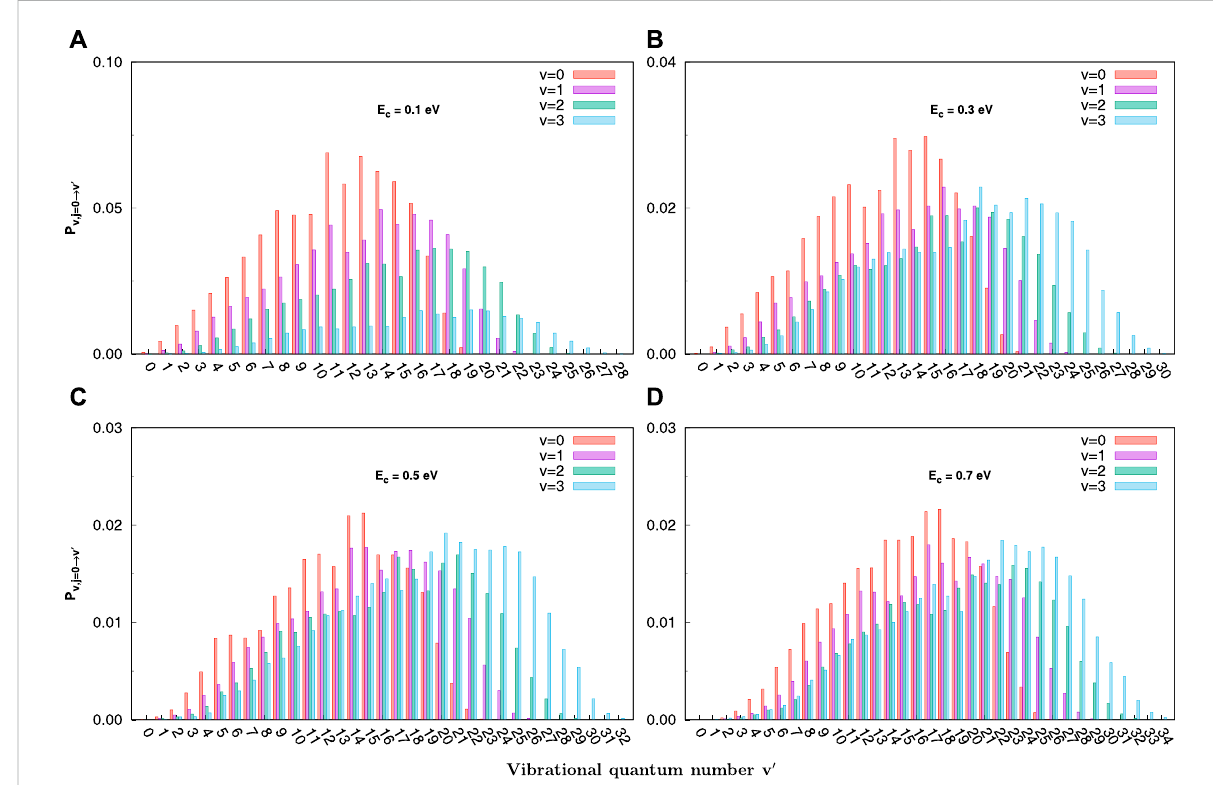
FIGURE 5 Final v ′ state-resolvedreactionprobabilitiesat J =0fortheC + +SH( v =0 − 3, j =0) → H+CS + ( v ′ )reactionatselectedcollisionenergies(0.1,0.3, 0.5, and 0.7 eV) obtained with the QCT method. (A) for 0.1 eV, (B) for 0.3 eV, (C) for 0.5 eV, (D) for 0.7 eV.